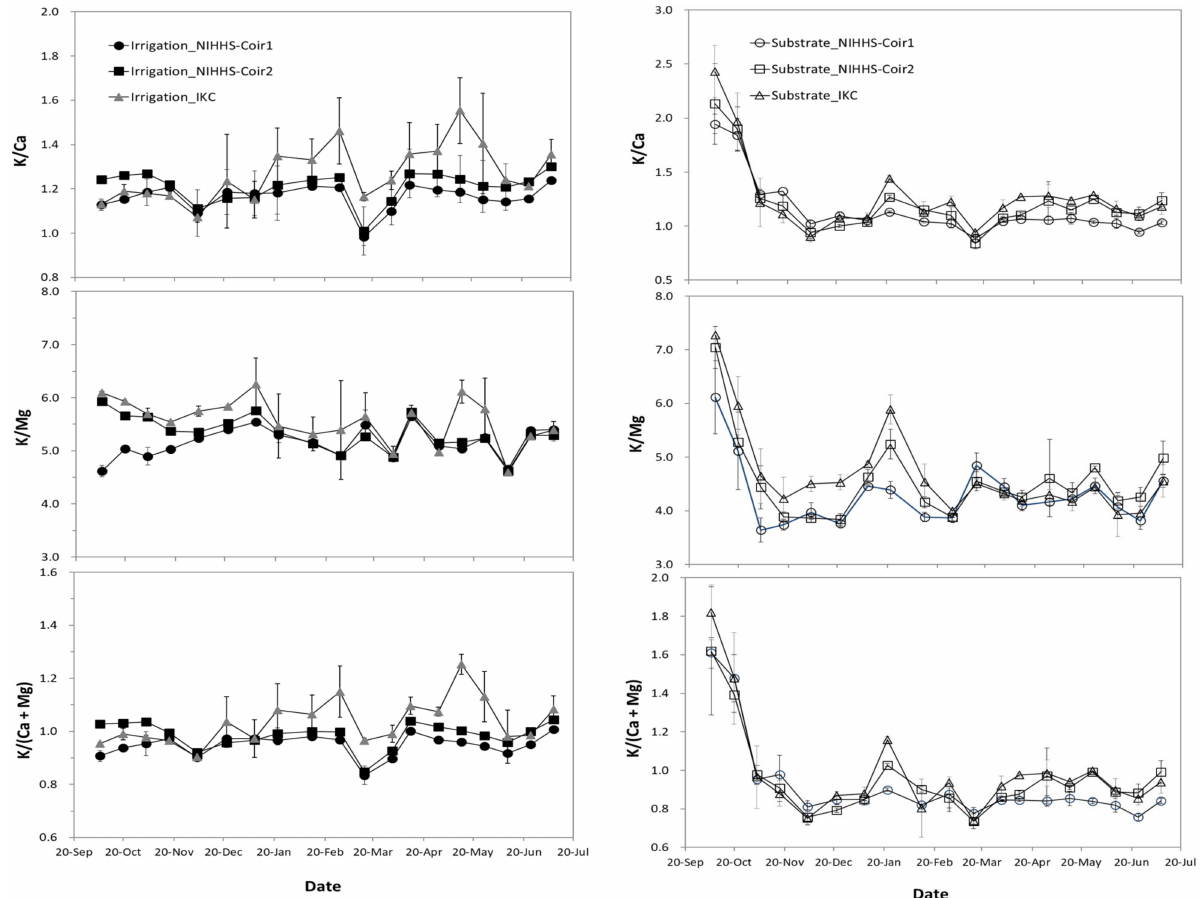
Figure 8. Changes in K/Ca, K/Mg, and K/(Ca + Mg) in the irrigation and RZ of each nutrient solution composition (NIHHS-Coir1, NIHHS-Coir2, and IKC) in the closed hydroponic system with a coir substrate. Vertical bars indicate standard errors of the means ( n =